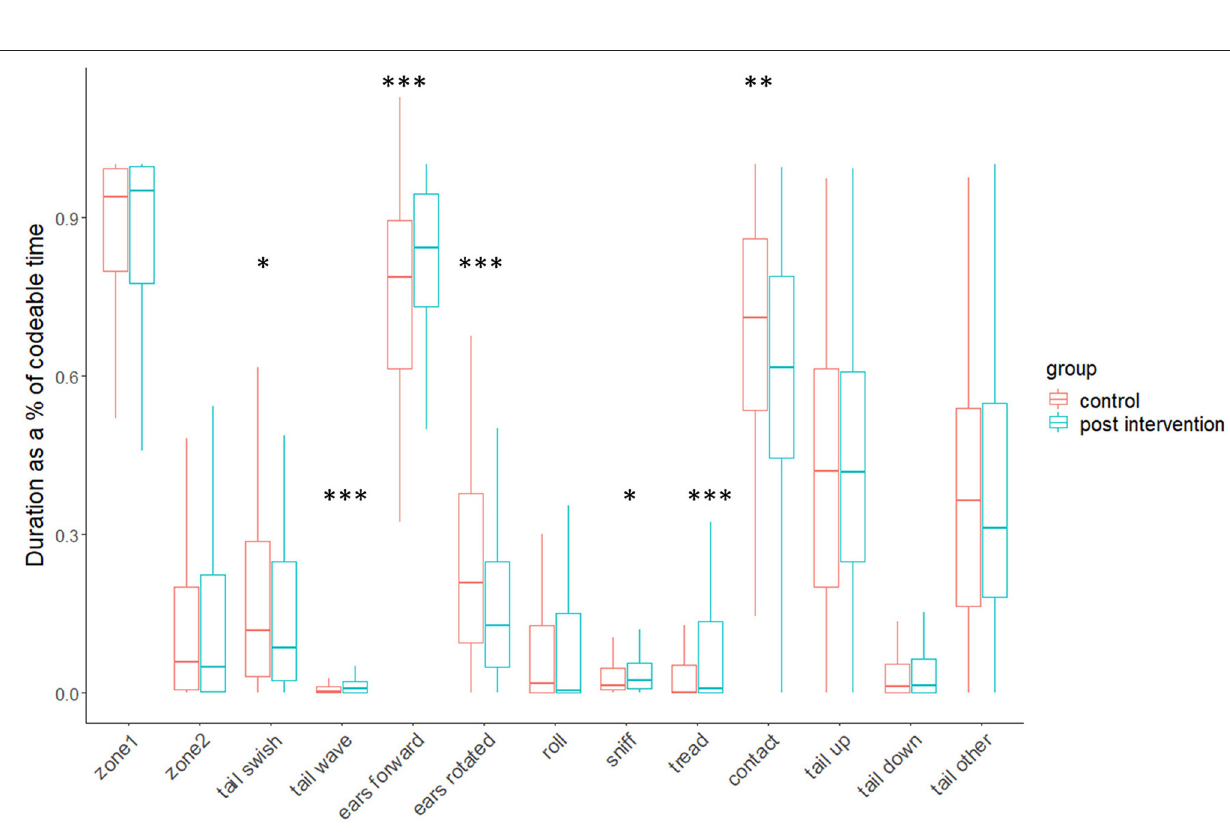
Frontiers in Veterinary Science |